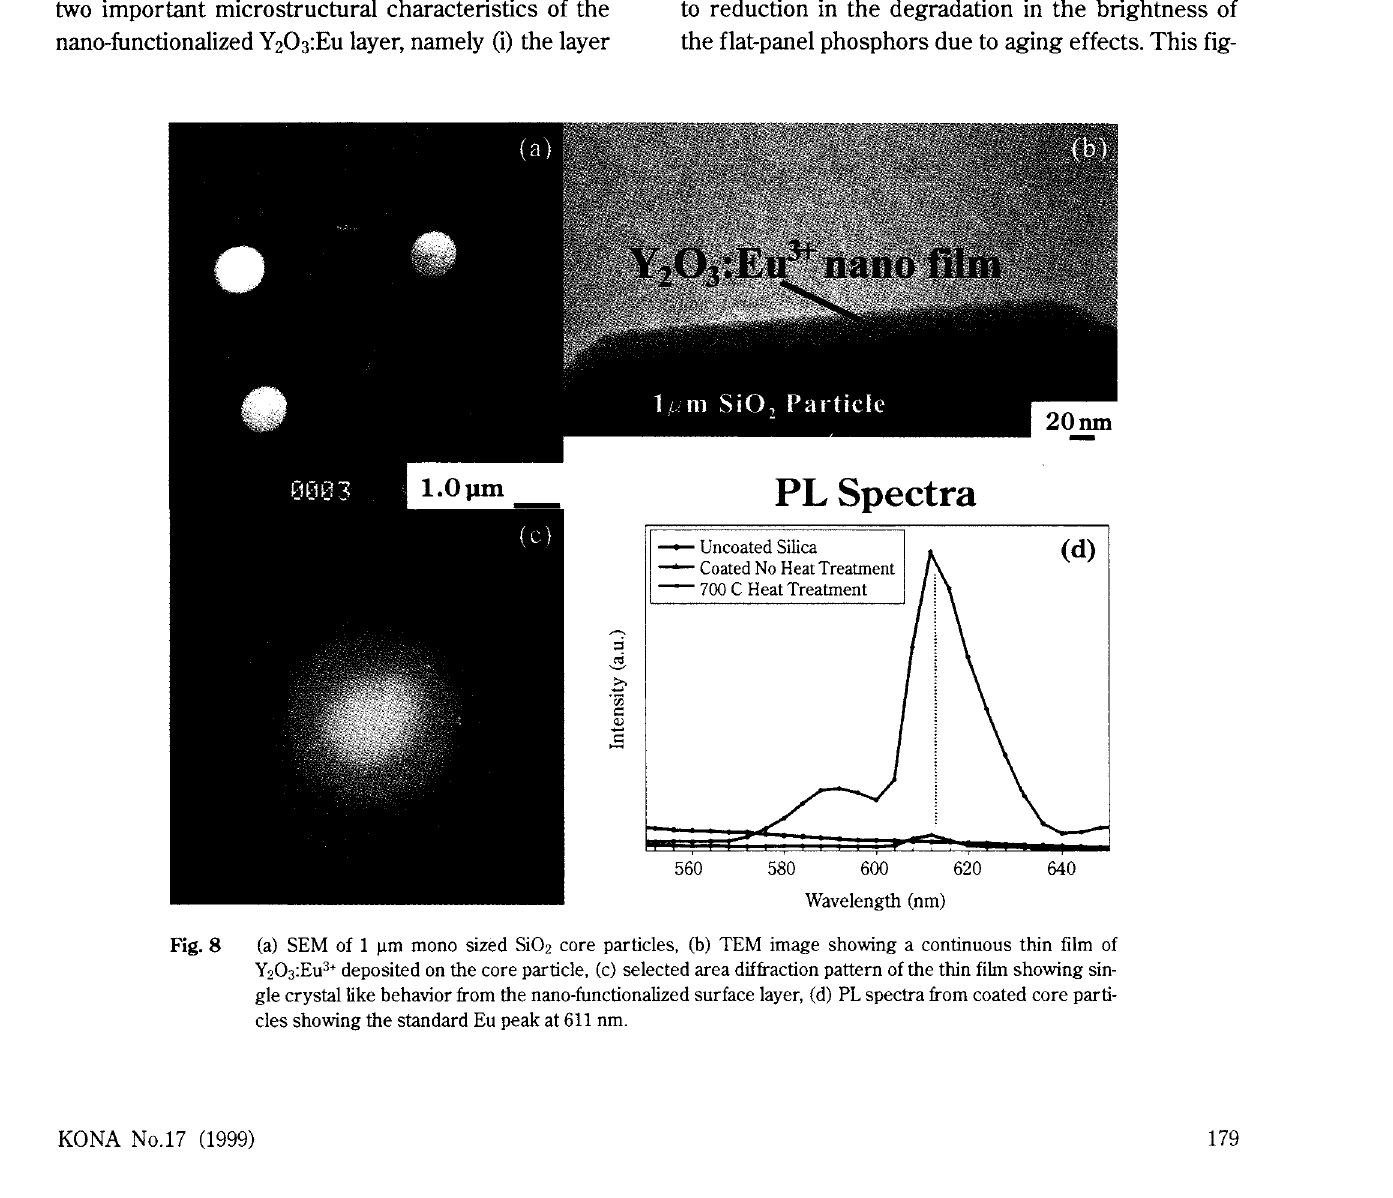
(a) SEM of 1 J.Lm mono sized Si0 2 core particles, (b) TEM image showing a continuous thin film of Y 2 0 3 :Eu 3• deposited on the core particle, (c) selected area diffraction pattern of the thin film showing sin gle crystal like behavior from the nano-functionalized surface layer, (d) PL spectra from coated core parti cles showing the standard Eu peak at 611